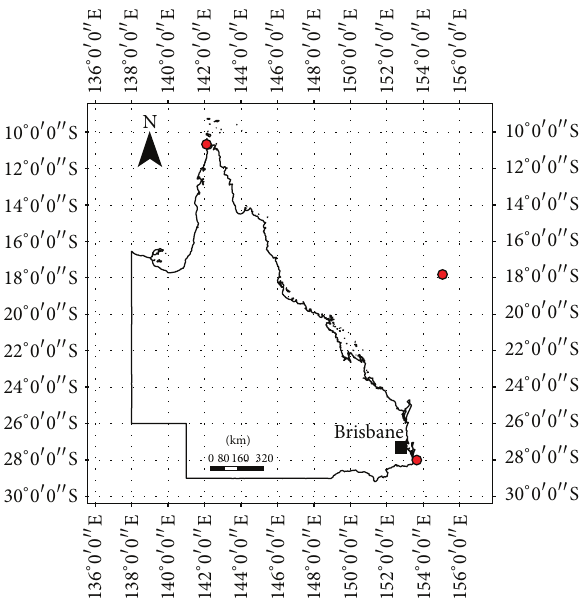
Figure 1: Map of Queensland coast showing the extents for which data was used. Red dots denote limits to study